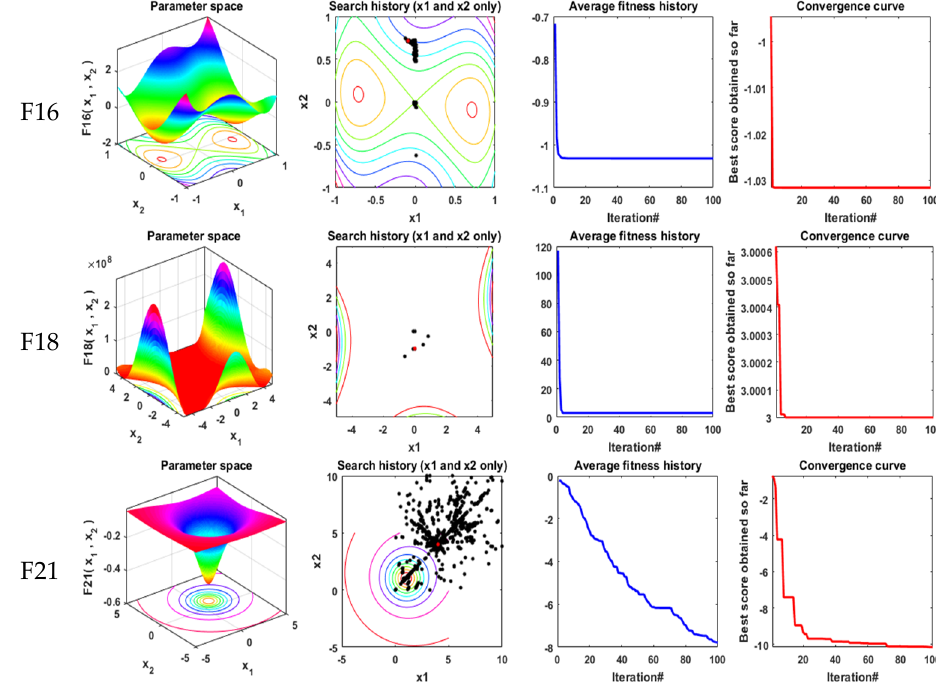
Figure 11. Qualitative metrics of nine benchmark functions: 2D views of the functions, search history, average fitness history, and convergence curve by the ESAOA technique. Table 4. Statistical results of 23 benchmark functions using the ESAOA algorithm and other recent algorithms.